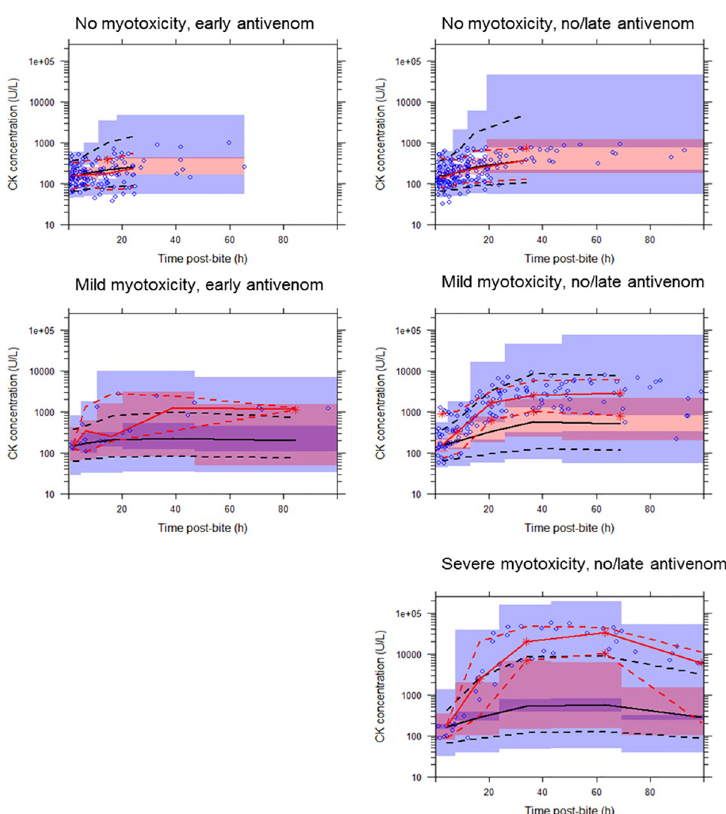
Fig 4. Visual predictive checks showing the observed timed creatine kinase (CK) concentration (U/L) versus time post-bite (h) described by a population kinetic-pharmacodynamic model with linear linker function to describe venom-effect relationship. The solid red line represents the median observed CK concentration, and the dashed lines represent the observed 10th and 90th percentiles. The solid black line represents the median simulated CK concentration, and the dashed lines represent the simulated 10th and 90th percentiles. Shaded areas are the corresponding 95% confidence intervals of the observed percentiles based on the simulated data. Patients data were categorised into three groups based on measured peak CK concentration: (a) no myotoxicity (CK < 1000 U/L); (b) mild myotoxicity (1000 U/L < CK < 10,000 U/L); and (c) severe myotoxicity (CK > 10,000 U/L). Plots on the left panel are for patients that received early antivenom (within 6 hours), and on the right are those that received no or late antivenom.